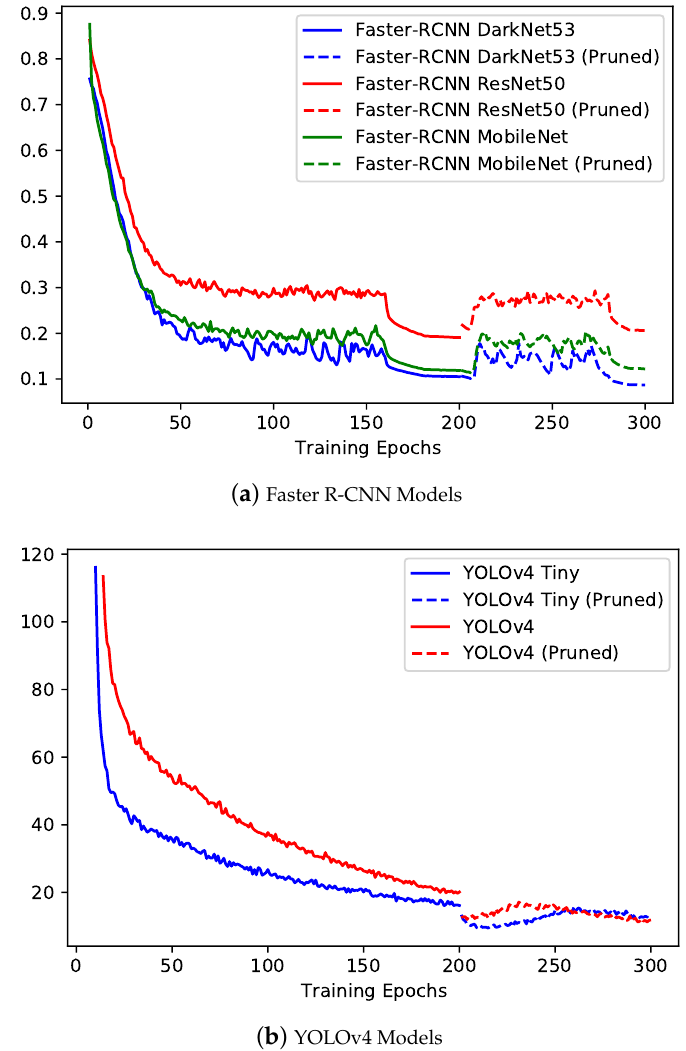
Figure 7. Training loss curves for the different variants of computer vision object detection models implemented for plastic-bag contamination Detection.